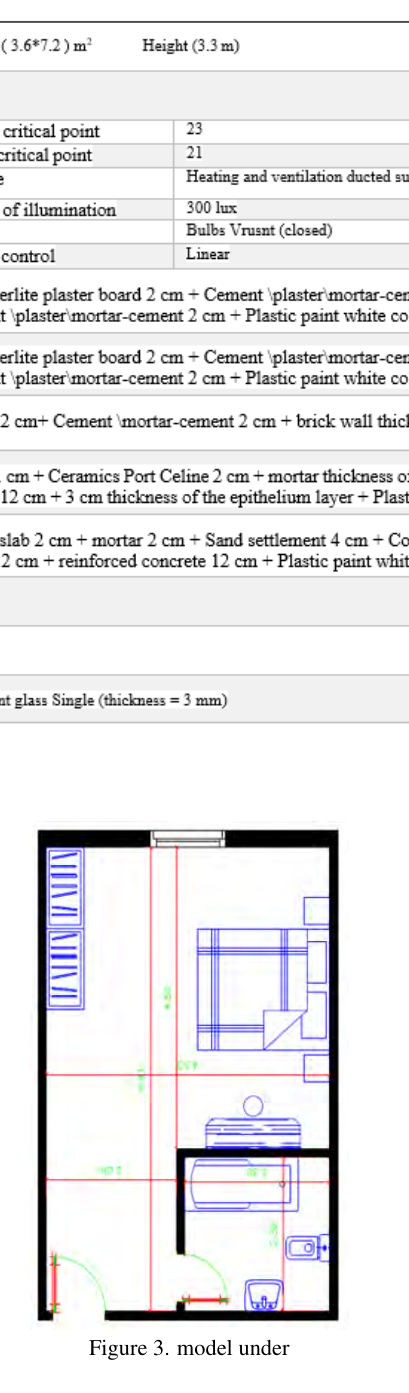
Table 1: Research sample characteristics